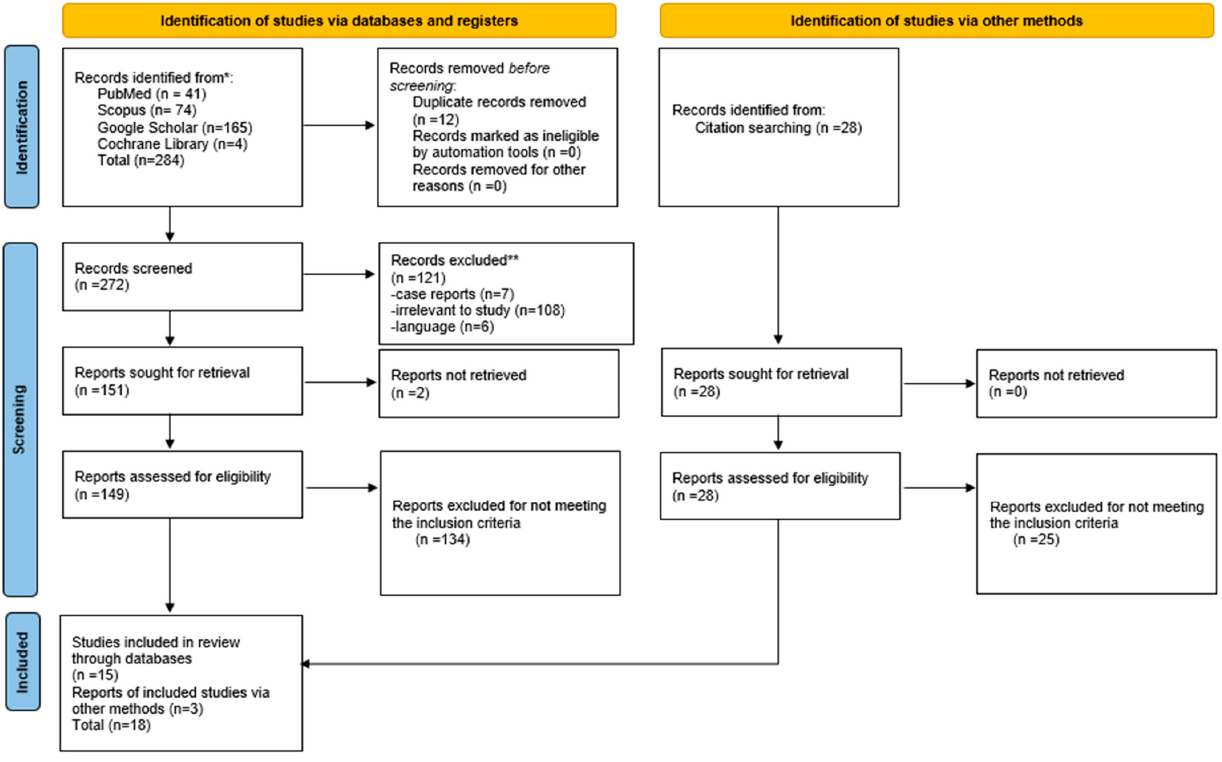
Figure 1. PRISMA flow diagram. Table 1. Search terms used in search strategy.